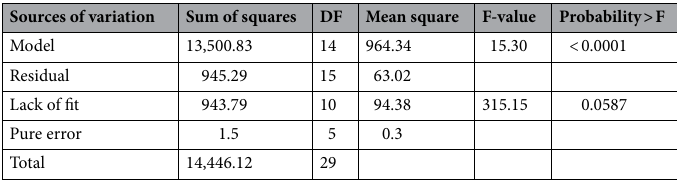
2 = 0.9346; DF degree of